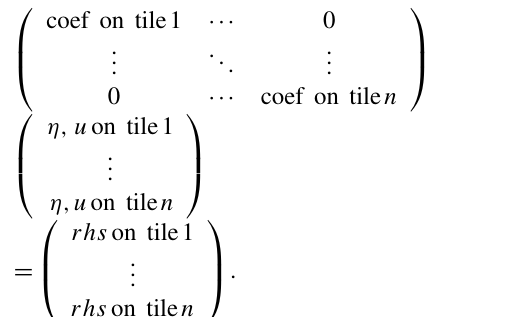
system whose size is twice the number of points in a